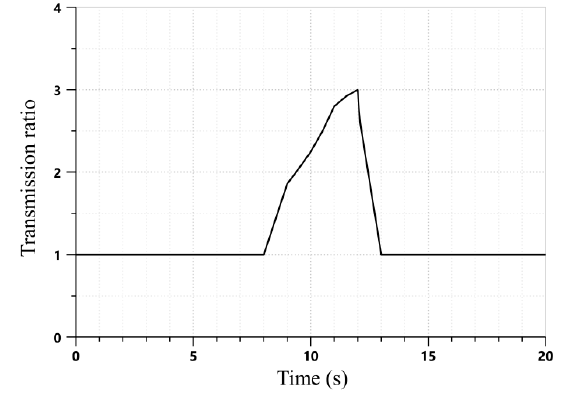
Figure 17. The varying transmission ratio.